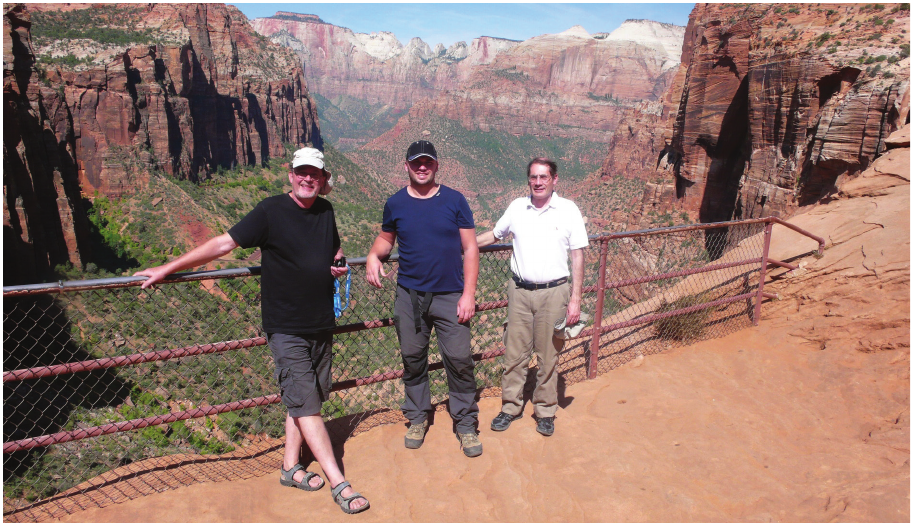
Figure 2. Pre-meeting sightseeing stop at Zion National Park, Utah. Left to right: Wolfgang Schawaller, René Fouquè, Gustavo